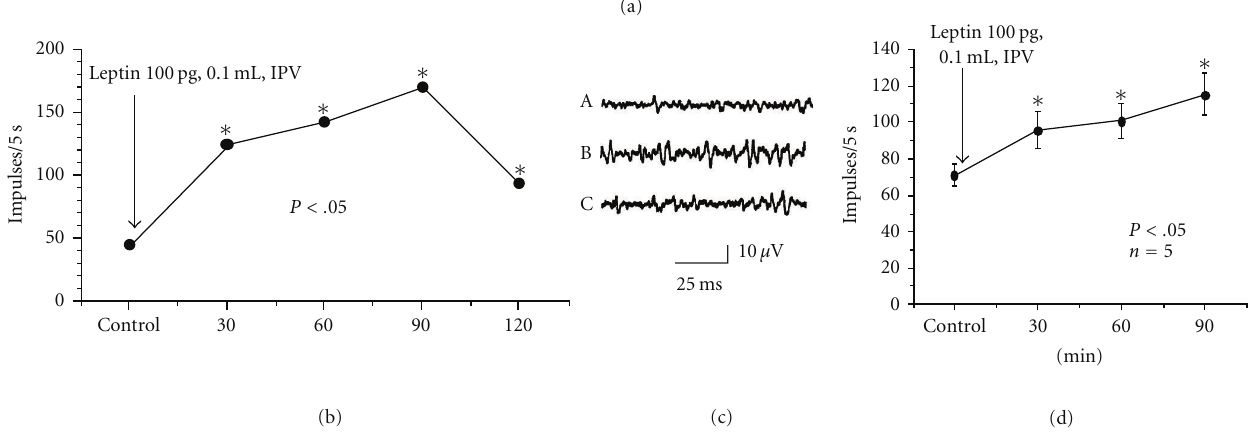
Figure 2: E ff ect of intraportal injection (IPV) of leptin 100 pg on a ff erent activity of the hepatic branch of the vagus nerve. (a) Time course of a ff erent activity before and after injection. Vertical bar: 100 impulses/5 seconds. The arrow shows the time of injection. (b) A ff erent discharge rate just before 30, 60, 90, and 120 minutes after injection. (c) A ff erent nerve activity (A) just before injection, (B) 60 minutes, and (C) 110 minutes after injection. (d) E ff ect of IPV injection of leptin (100pg, 0.1 mL) on mean discharge rates of vagal hepatic a ff erents ( n = 5). ∗ Shows significant increase in discharge rates from the control value just before